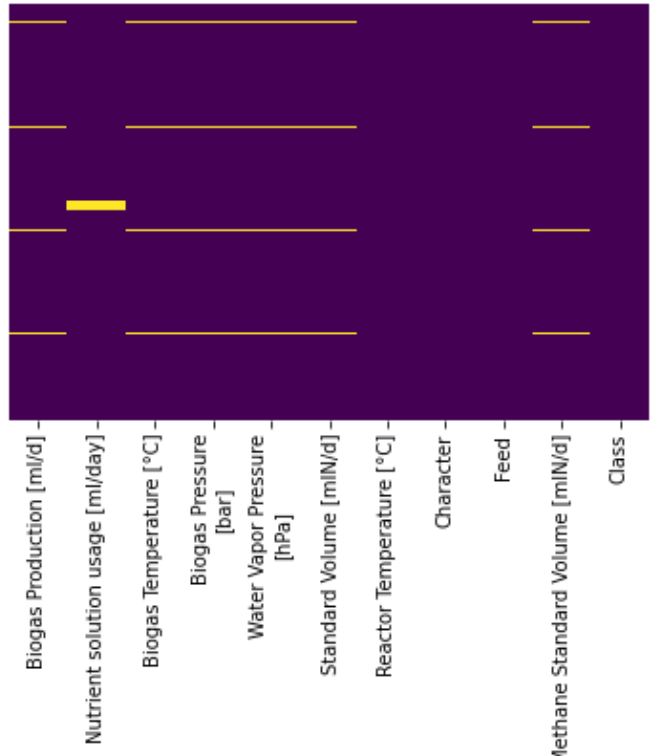
Figure 2. ( a ) Original and grinded pellets; ( b ) feeding and discharging bottles in the fridge; ( c ) CSTR reactors.